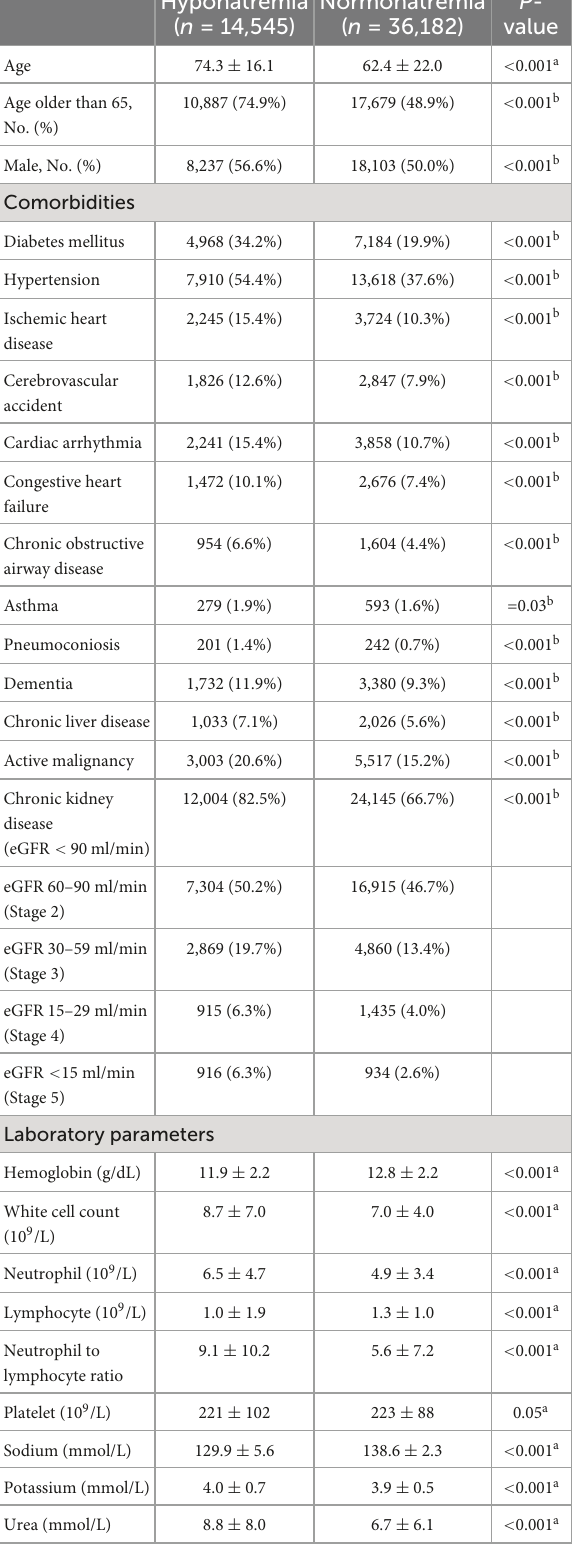
TABLE 1 Clinical characteristics of COVID-19 patients with or without hyponatremia at